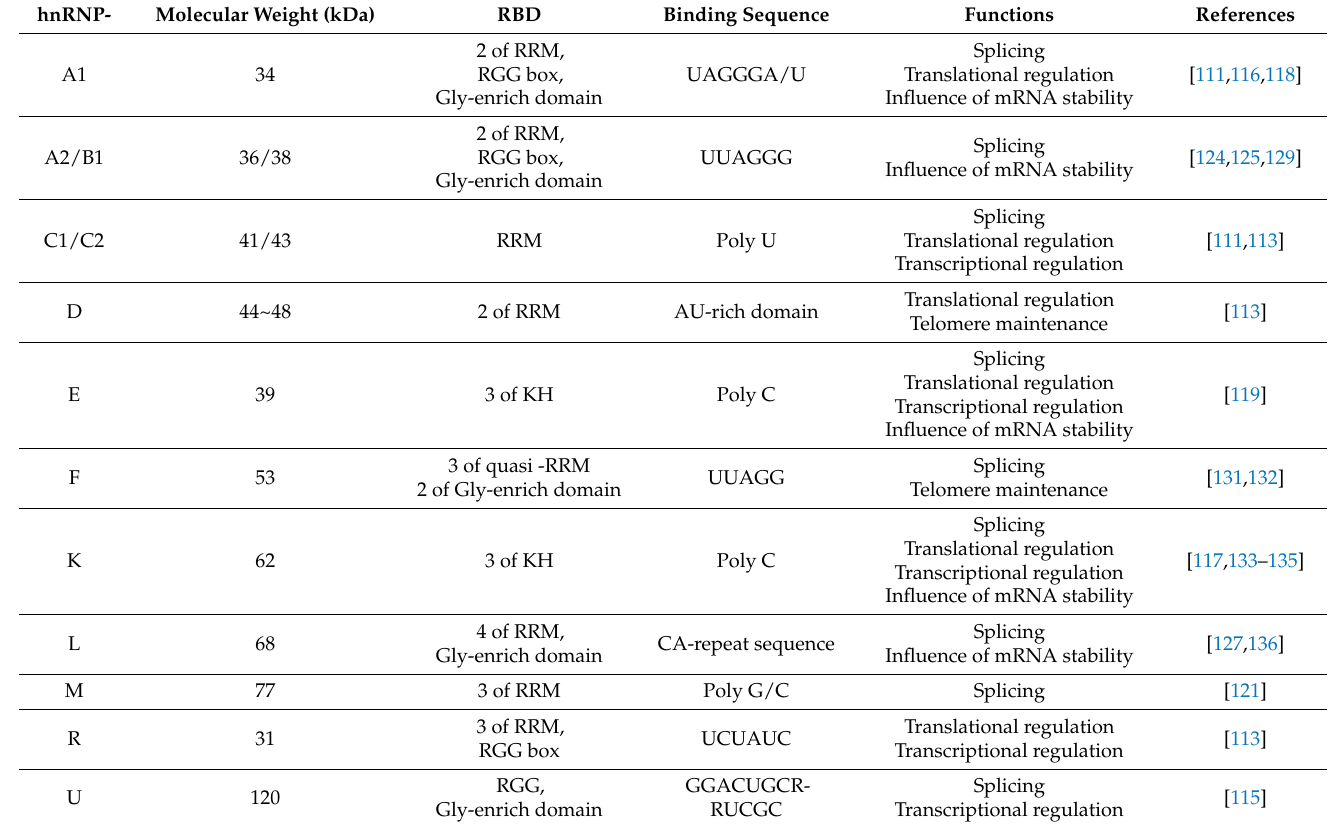
Table 1. The hnRNP family presented by their structural and functional characteristics, and its interacting